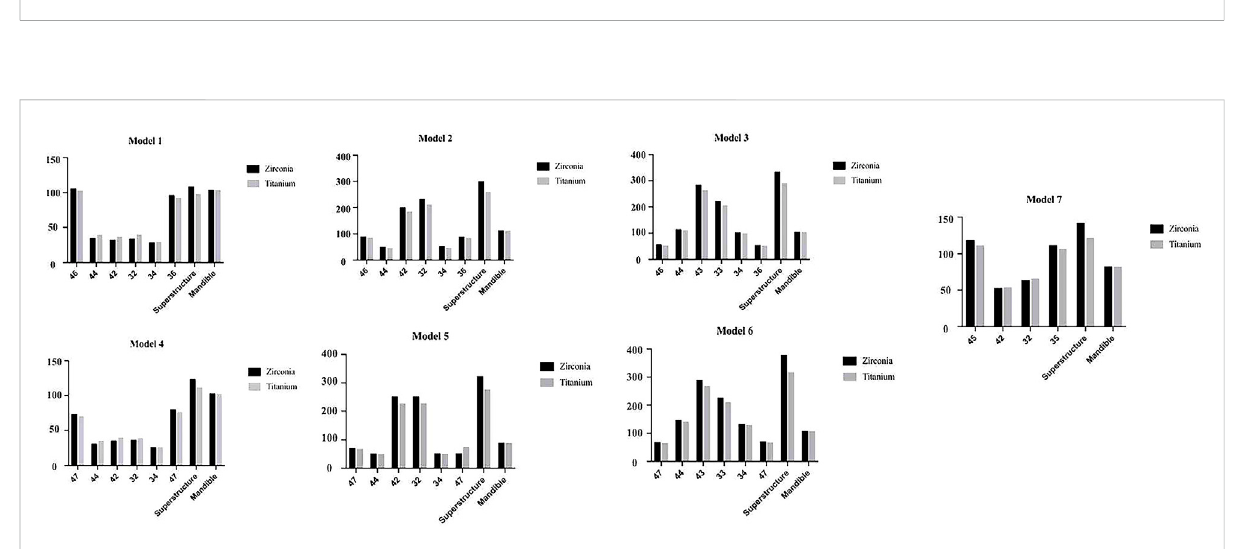
FIGURE 10 Maximum von Mises stresses on mandible and prostheses with different materials in mesofacial